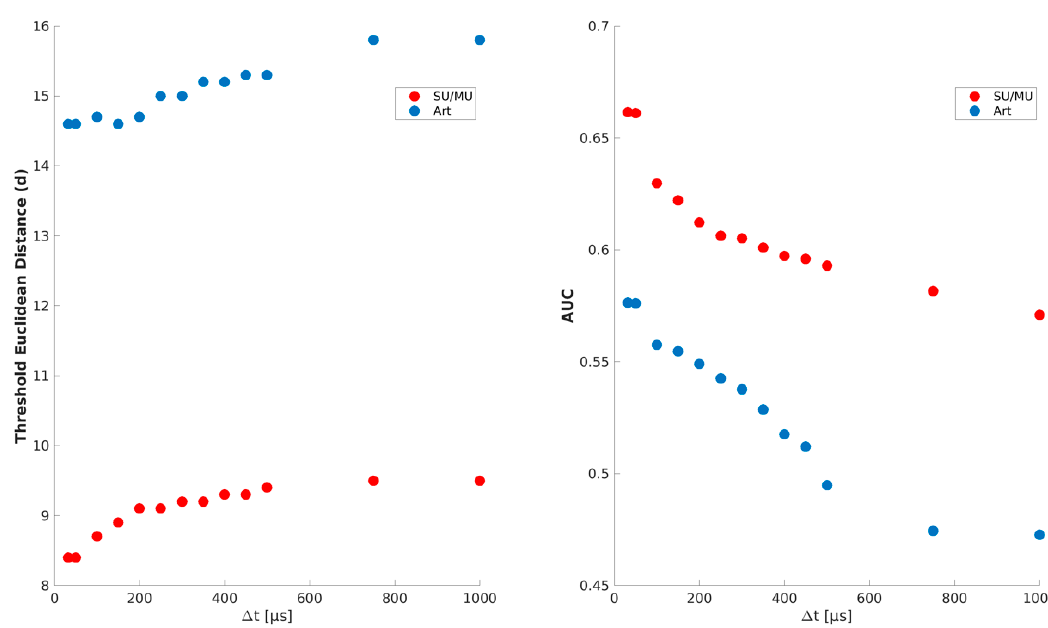
Figure A1. Thresholds of Euclidean distance ( left ) and AUC ( right ) for different time windows. Each point in the left subfigure represents the operating point in an ROC curve calculated from surrogate and real distributions of Euclidean distances for clusters manually labeled as units (MU/SU) or artifacts (Art). See Sections 2.3.2 and 2.4.2.